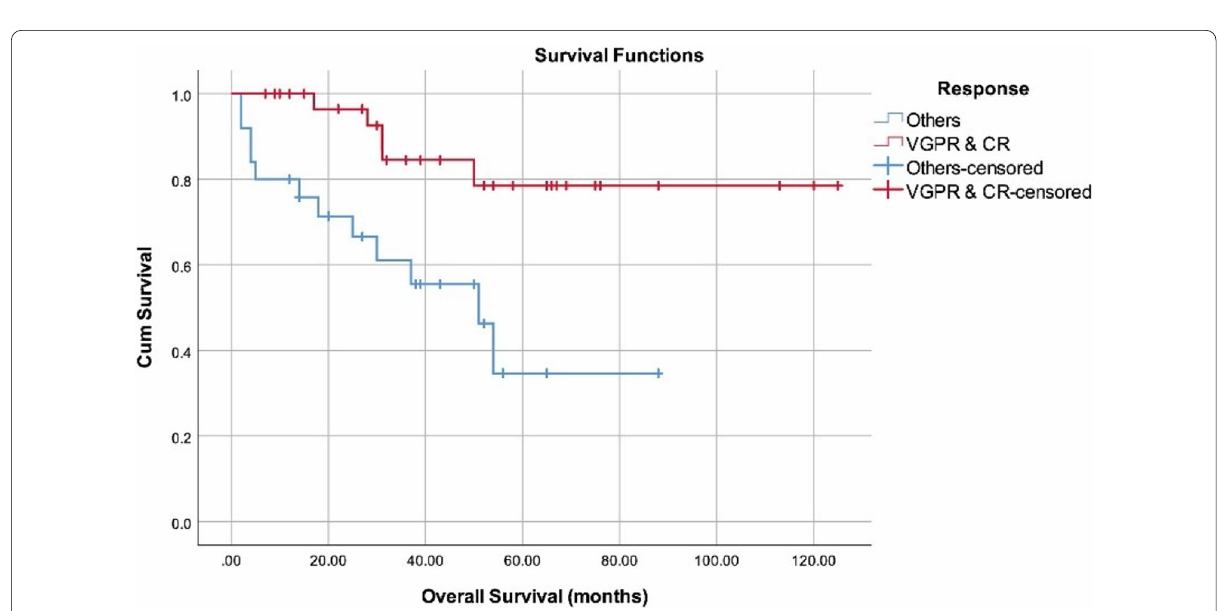
Fig. 3 Overall survival by first-line treatment